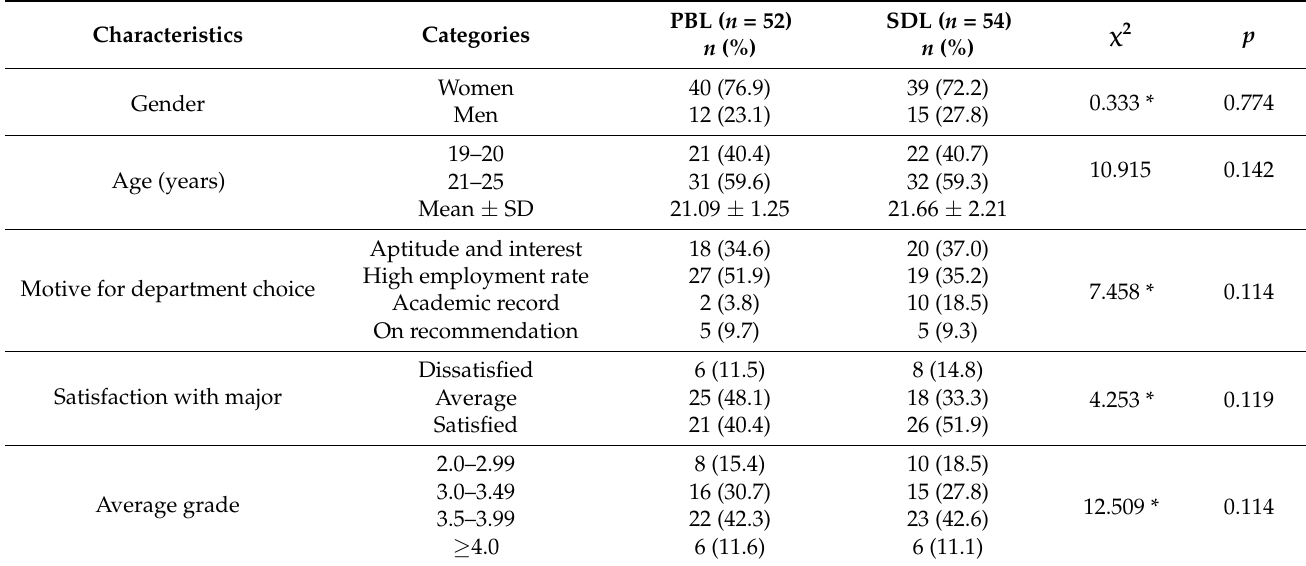
Table 1. Baseline characteristics of the PBL and SDL